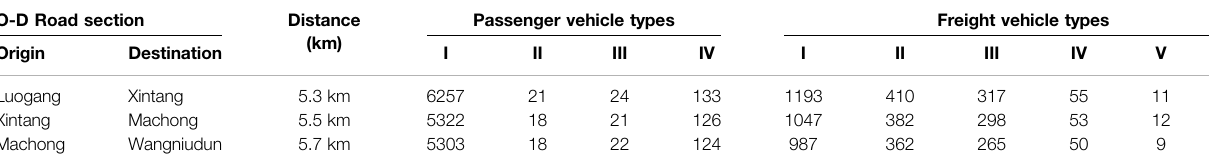
TABLE 1 | Part of the O-D traf fi c fl ow data. O-D Road